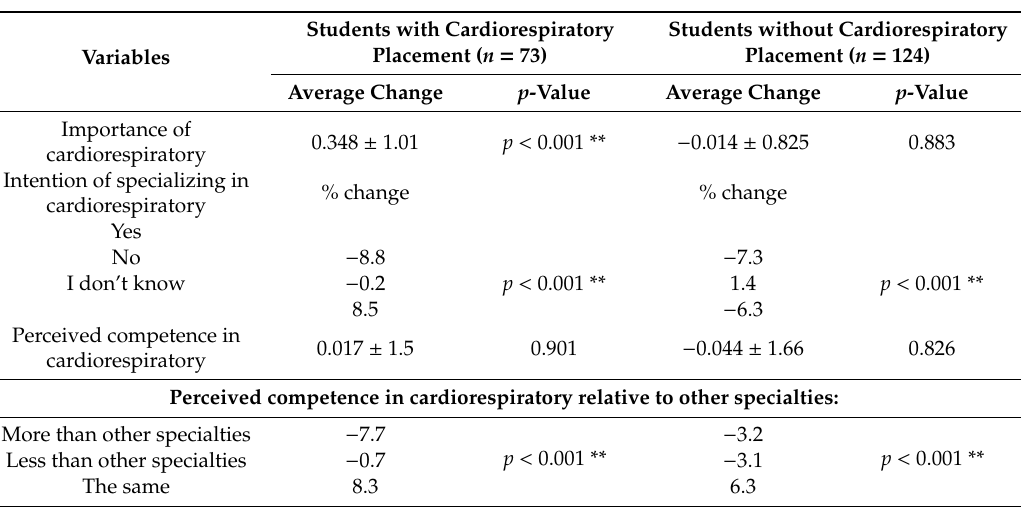
Table 3. Changes between pre-placement and post-placement values assigned to competence, importance, and interest in cardiorespiratory physiotherapy of all the students included in the study by